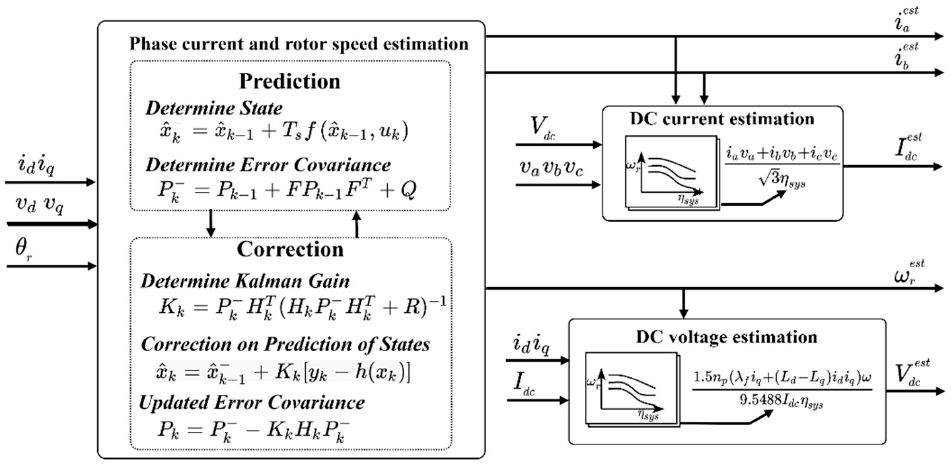
Figure 8. Estimation module.